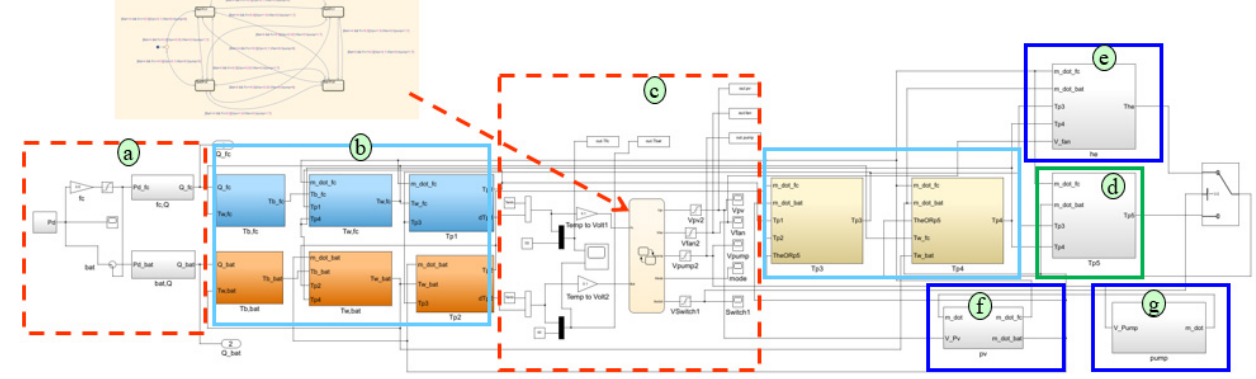
Figure 4. The IHTMS simulator on the Matlab/Simulink platform.